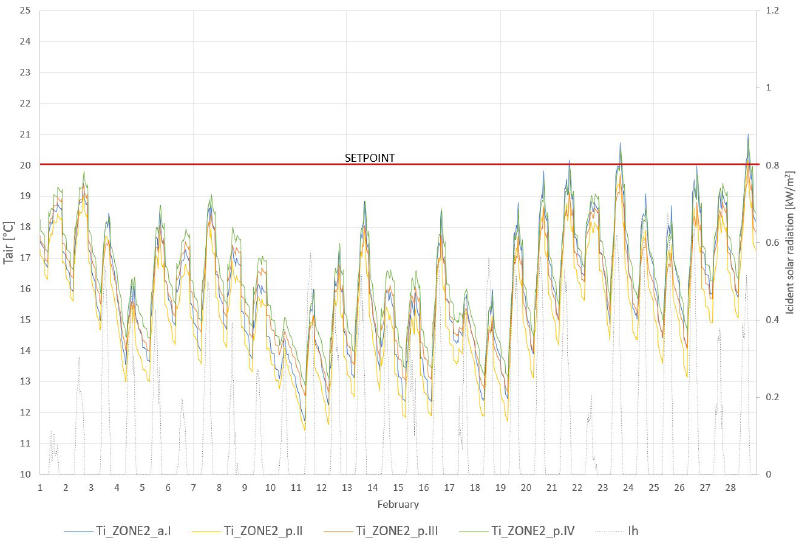
Energies 2022 , 15 , x FOR PEER REVIEW Figure 13. Effects of glazing systems on mean indoor air temperature; winter period: February (floor 2).